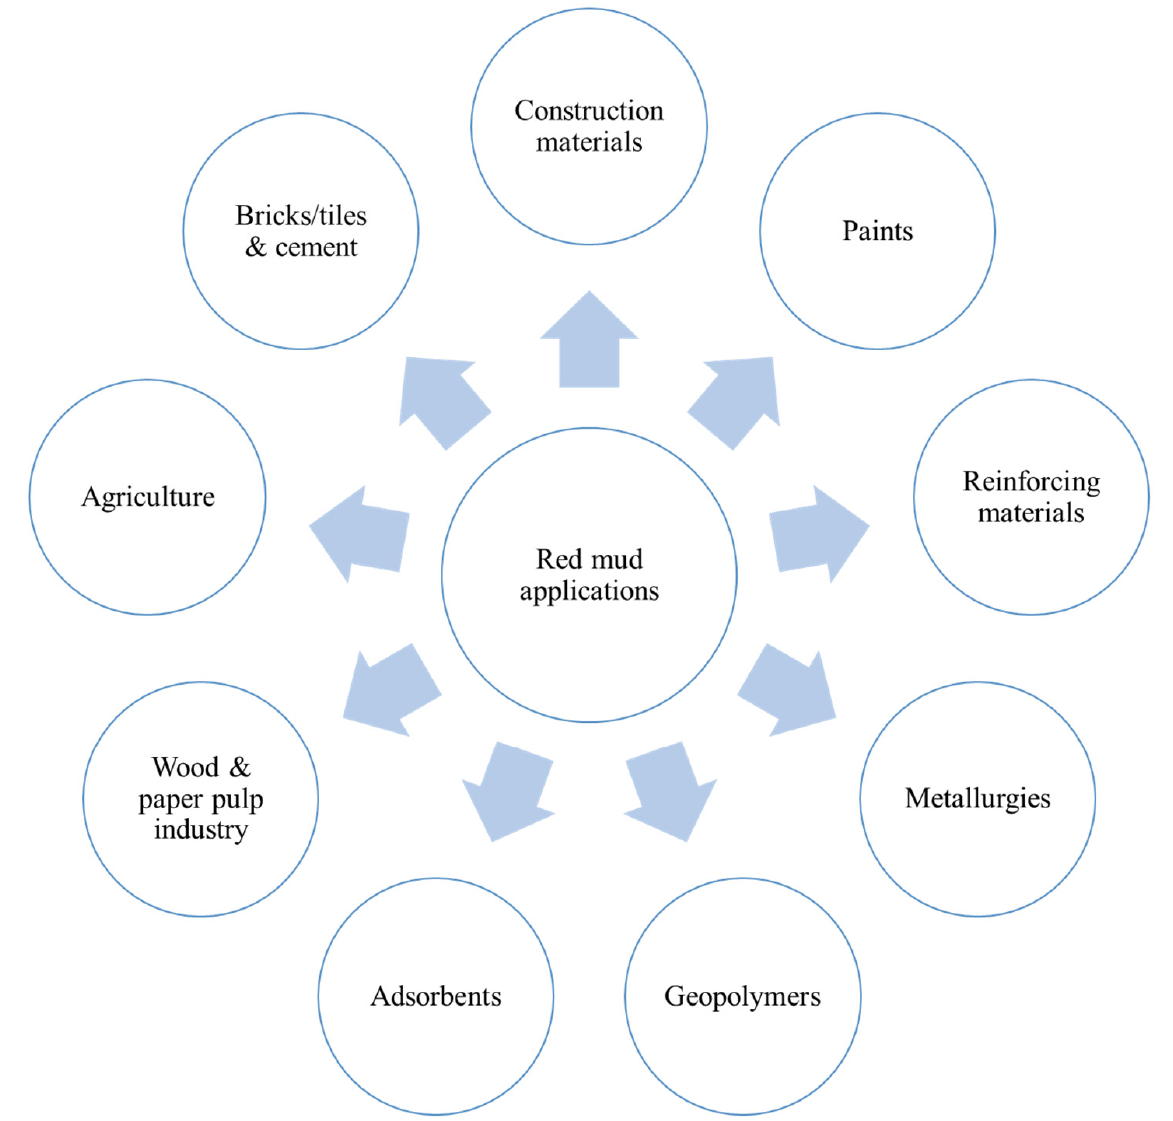
Figure 6. Diagrammatic representation of red mud in their broader